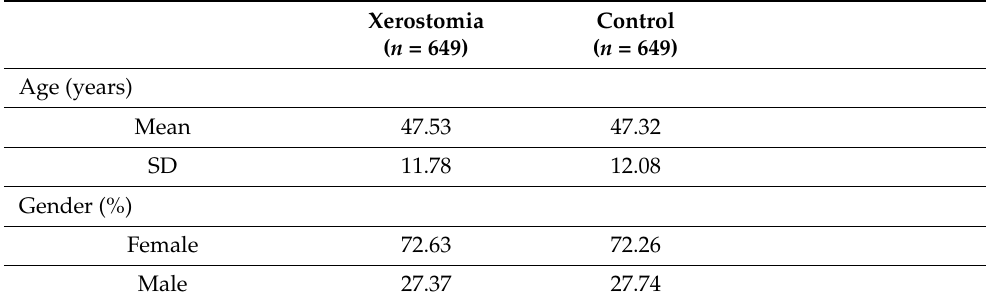
Table 1. Demographics and descriptive analysis of the dental status and caries risk factors of n = 1298 adults under age 65 (Chi-squared, Wilcoxon Signed Rank